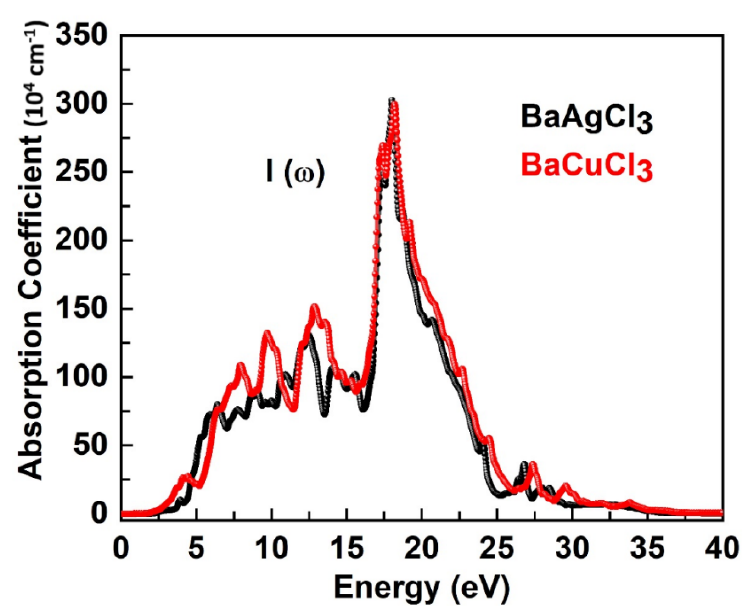
Figure 9. The absorption coefficient of ternary BaAgCl 3 and BaCuCl 3 chloroperovskites compounds.